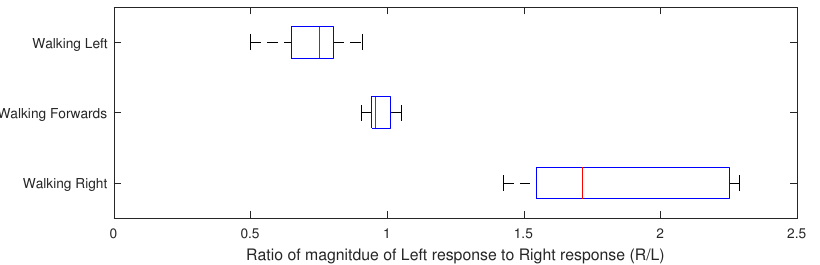
Figure 12. Ratio of the magnitude of the calf response for the Right calf muscle sensor to the left calf muscle sensor for different directions of walk.20 results were recorded for each direction of